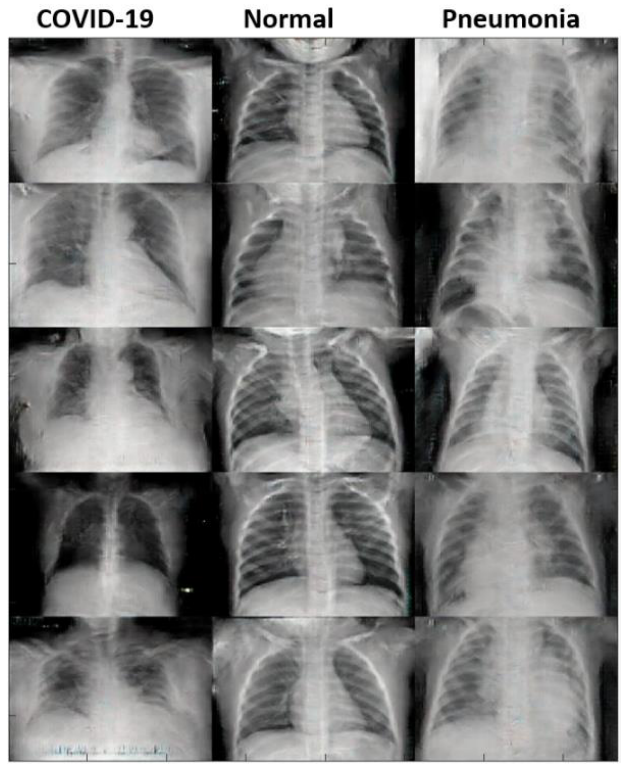
Figure 8. Sample of the generated images from the three classes by the CGAN.